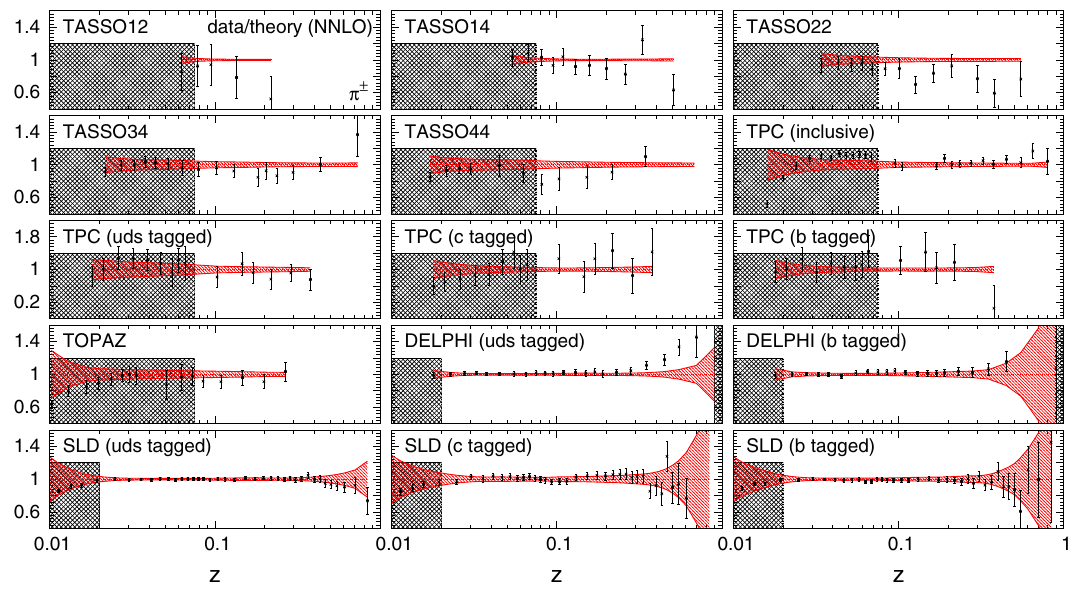
Fig. 6 The data/theory ratio for the charged pion data included in the NNFF1.0 fit and not accounted for in Figs. 4 and 5. As before, theoret- ical predictions are computed at NNLO with our best-fit NNLO FFs,